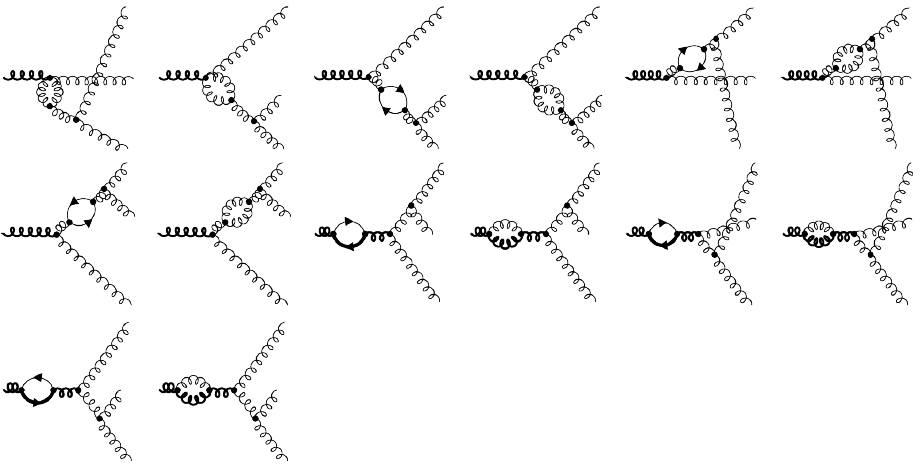
Figure 6 . Part of the 68 diagrams contributing to the splitting operator g → ggg . Description as in figure